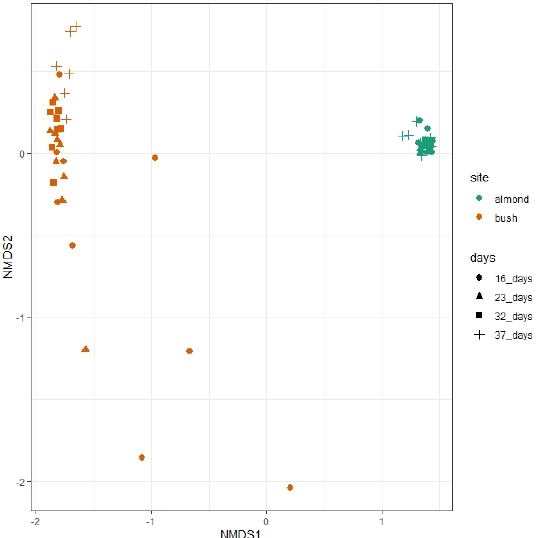
Figure 9. Non-metric multiple dimension scaling (nMDS) ordination plot showing dissimilarities in